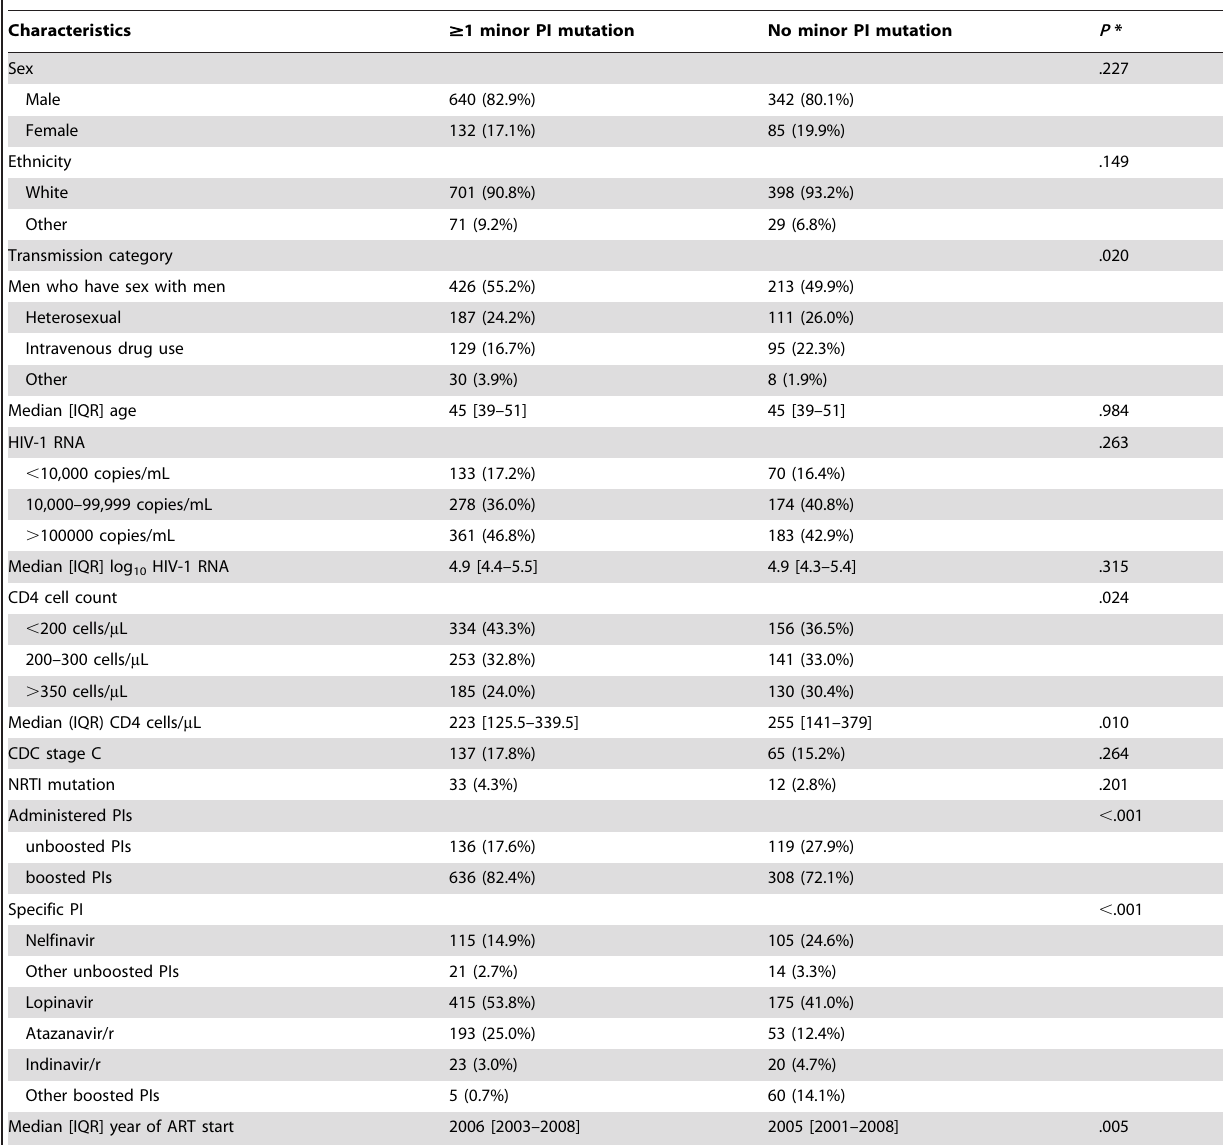
Table 1. Baseline